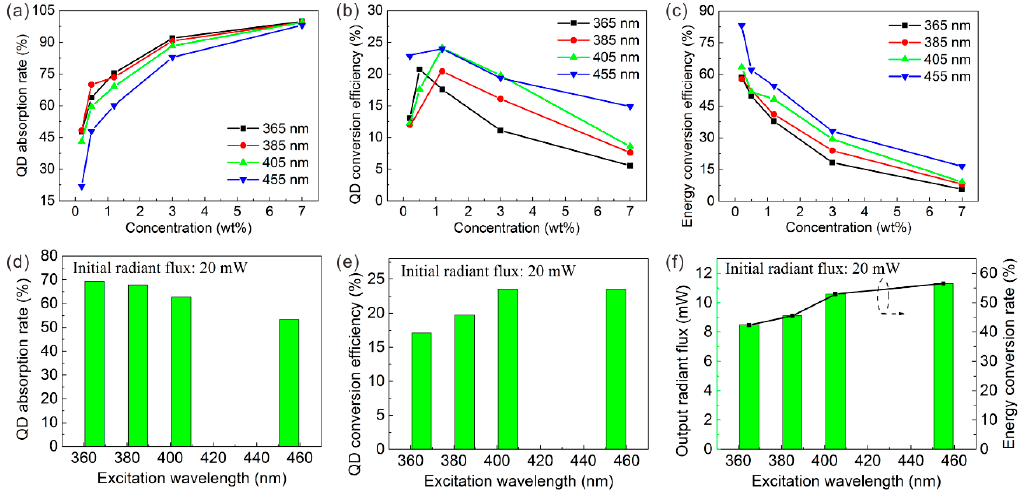
Figure 7. ( a , d ) QD absorption rate, ( b , e ) QD conversion efficiency, and ( c , f ) energy conversion efficiency of GQD LED with different excitation wavelengths.